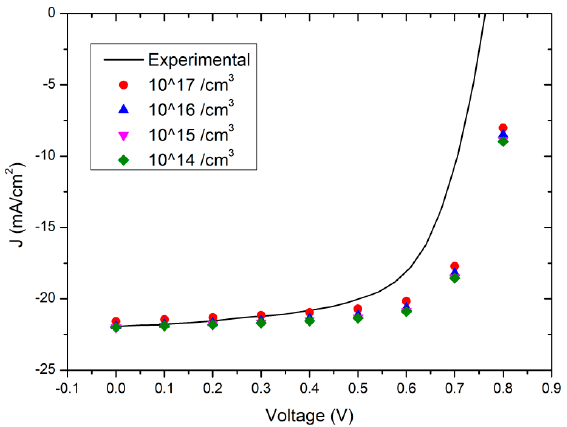
Figure 8. The comparison of our experimental data and theoretical model.